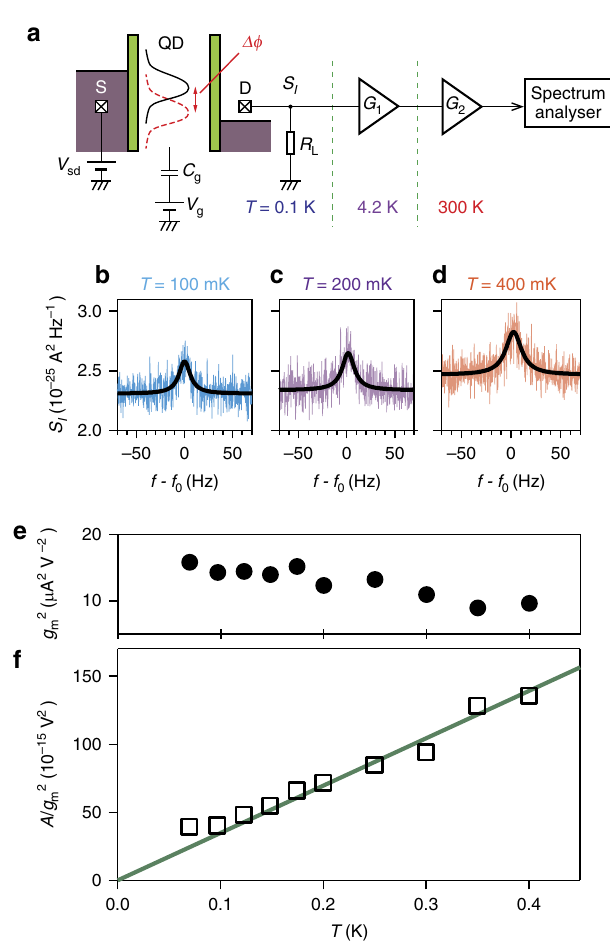
Figure 2 | Thermal motion measured via the quantum dot current. ( a ) A schematic of the experimental setup for measuring thermal motion of the mechanical resonator. The potential fluctuation Df induced by the piezoelectric field associated with the mechanical thermal motion results in current fluctuations, which are fed into a load resistor R L ¼ 1k O and the voltage drop across the load is amplified by cryogenic ( G 1 ) and room- temperature ( G 2 ) amplifiers (see Methods). The resultant amplified signal is measured with a spectrum analyser. ( b – d ) The current power spectral density S I around f 0 at three different temperature. The bold solid line shows a Lorenzian fit, from which the peak area A corresponding to the squared amplitude of the mechanical motion is obtained. ( e , f ) Temperature dependence of the transconductance g m (cid:4) d I /d V sd ( e ) and A normalized by g m ( f ) along with a linear fit (solid